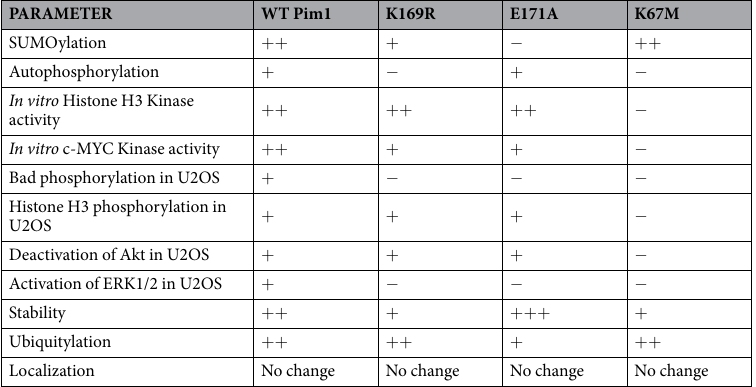
PARAMETER WT Pim1